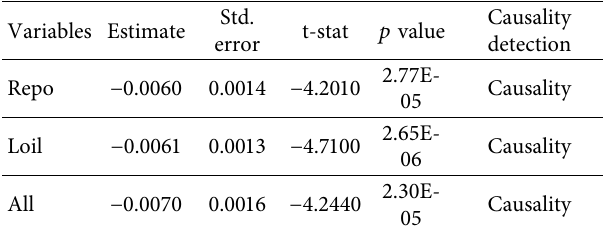
Table 3: Engle and granger causality test for output and input variables.